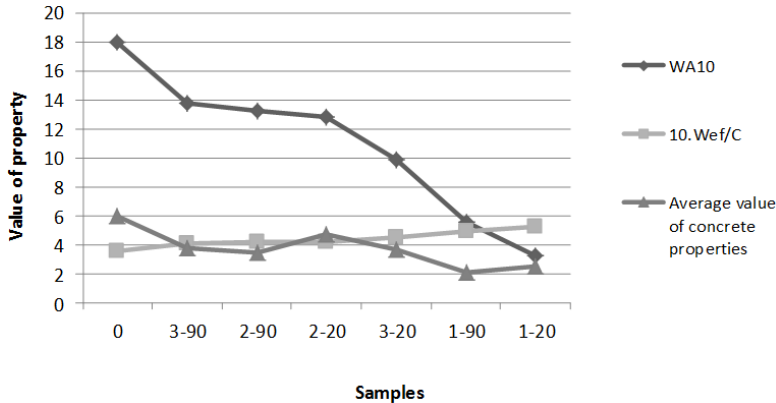
Figure 4. Relationships between water absorption capacity of RBA, effective amount of water in CRBA (concretes based on treated recycled brick aggregate), and final properties of CRBA.